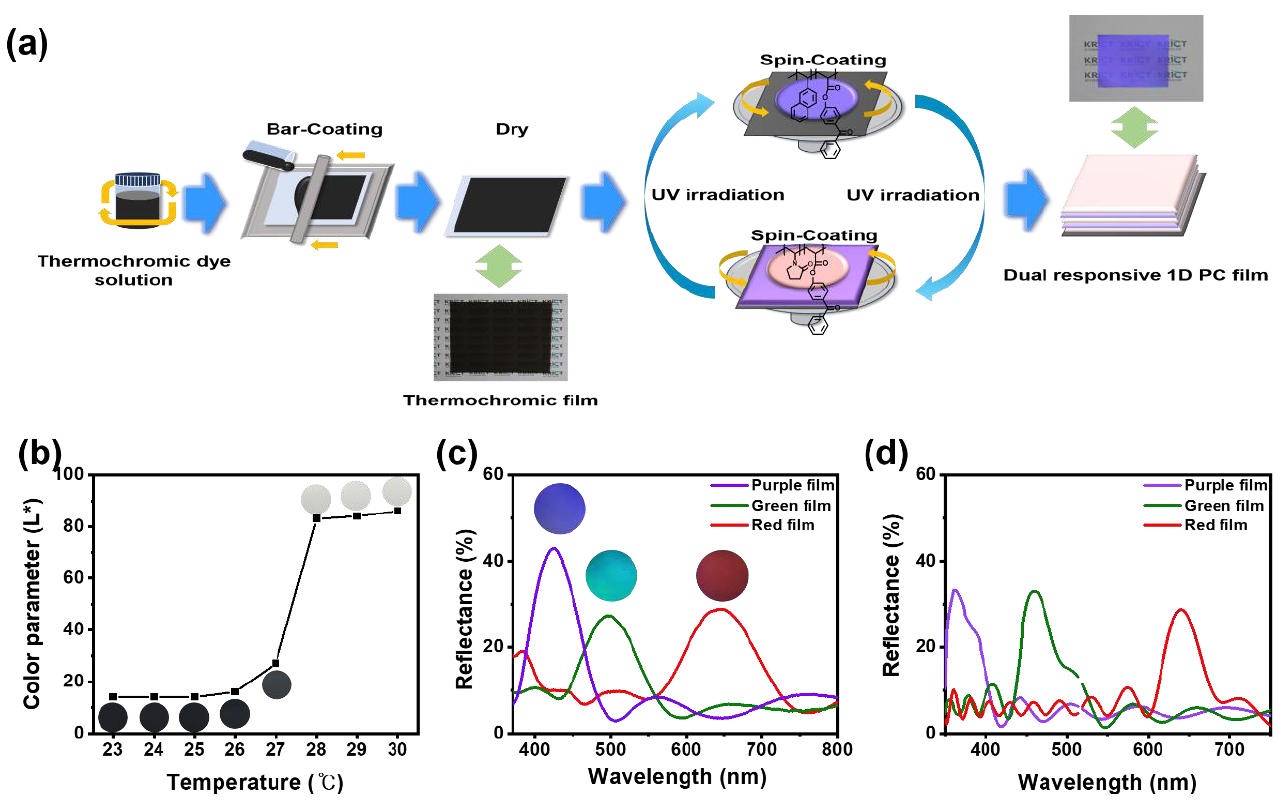
Figure 2. ( a ) Schematic depicting the fabrication method for a thermal and humidity responsive 1D PC multilayer via bar- and spin-coating processes. ( b ) Color parameter (L*) of thermochromic films with temperature. ( c ) Initial reflectance spectra of purple, green, and red films. ( d ) Theoretical reflectance spectra of purple, green, and red films via ellipsometry data.